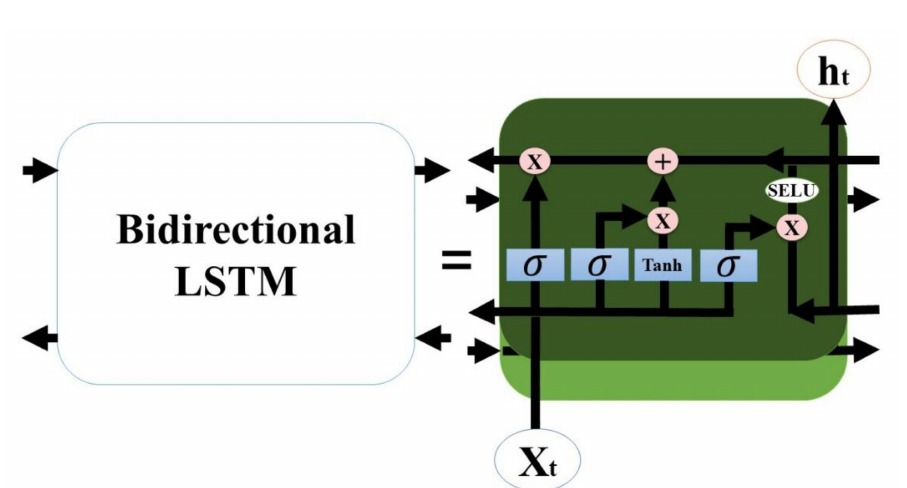
Figure 7. A detailed schematics of a Seq2Seq’s bidirectional LSTM